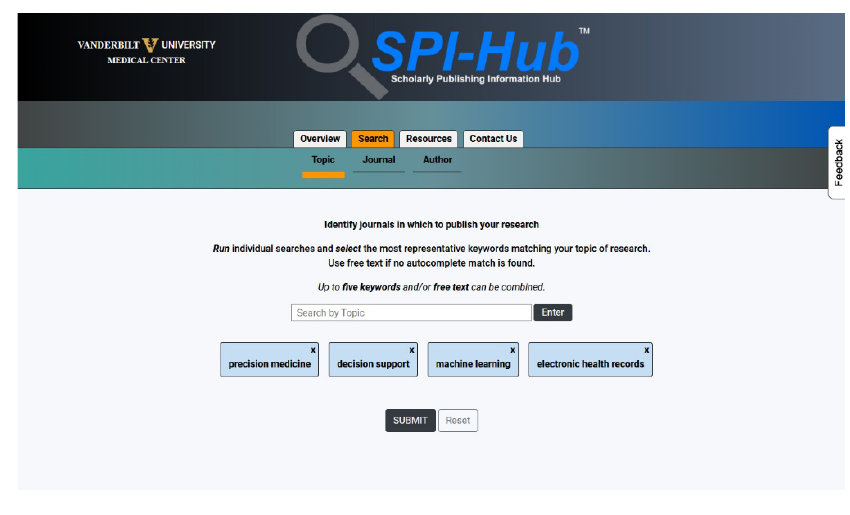
Figure 1 Example Search by Topic